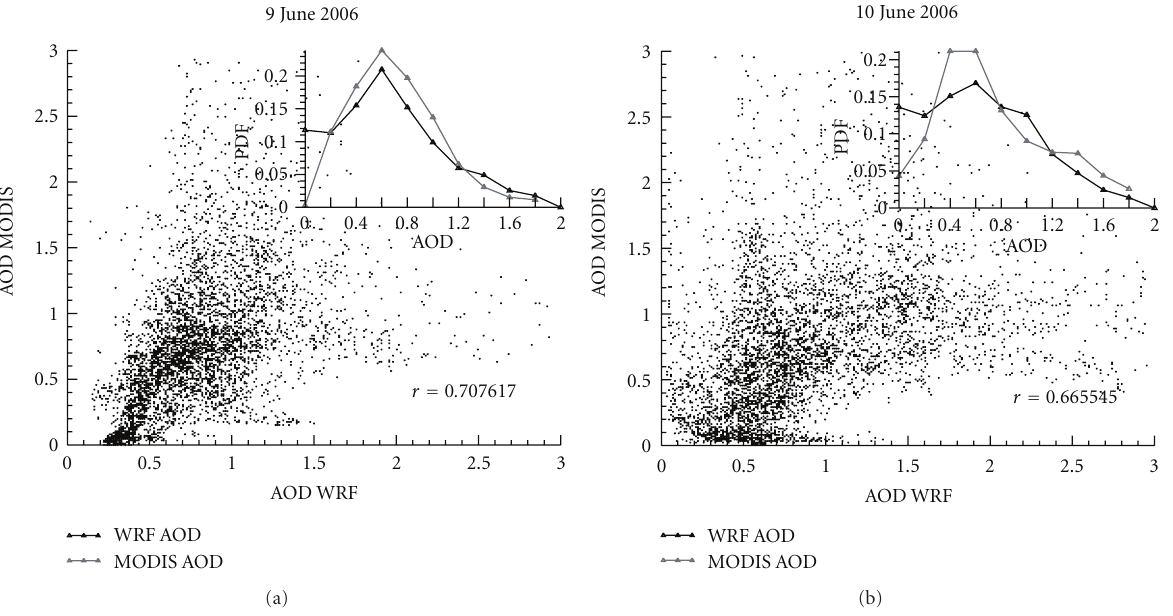
Figure 7: AOT scatter plots for 1200 UTC over model domain (a) the 9th of June and (b) the 10th of June. Main plots represent MODIS AOT versus Model AOT, and inner plots represent PDFs on the same datasets.